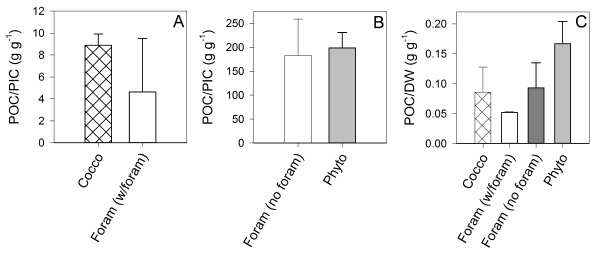
Fig. 7. Ratios of POC/PIC in (A) calcite-containing aggregates and in (B) aggregates lacking calcite and ratios of (C) POC to dry weight in all aggregates.